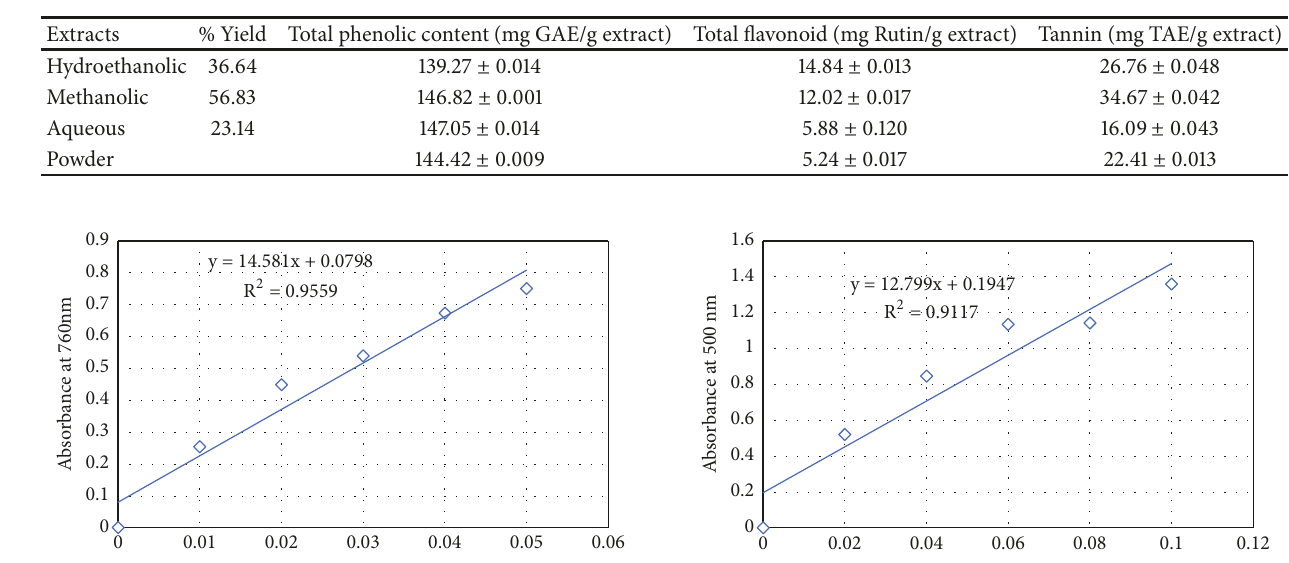
Table 1: Percent yield, content of total polyphenols, flavonoids, and tannins contained in C. edulis .